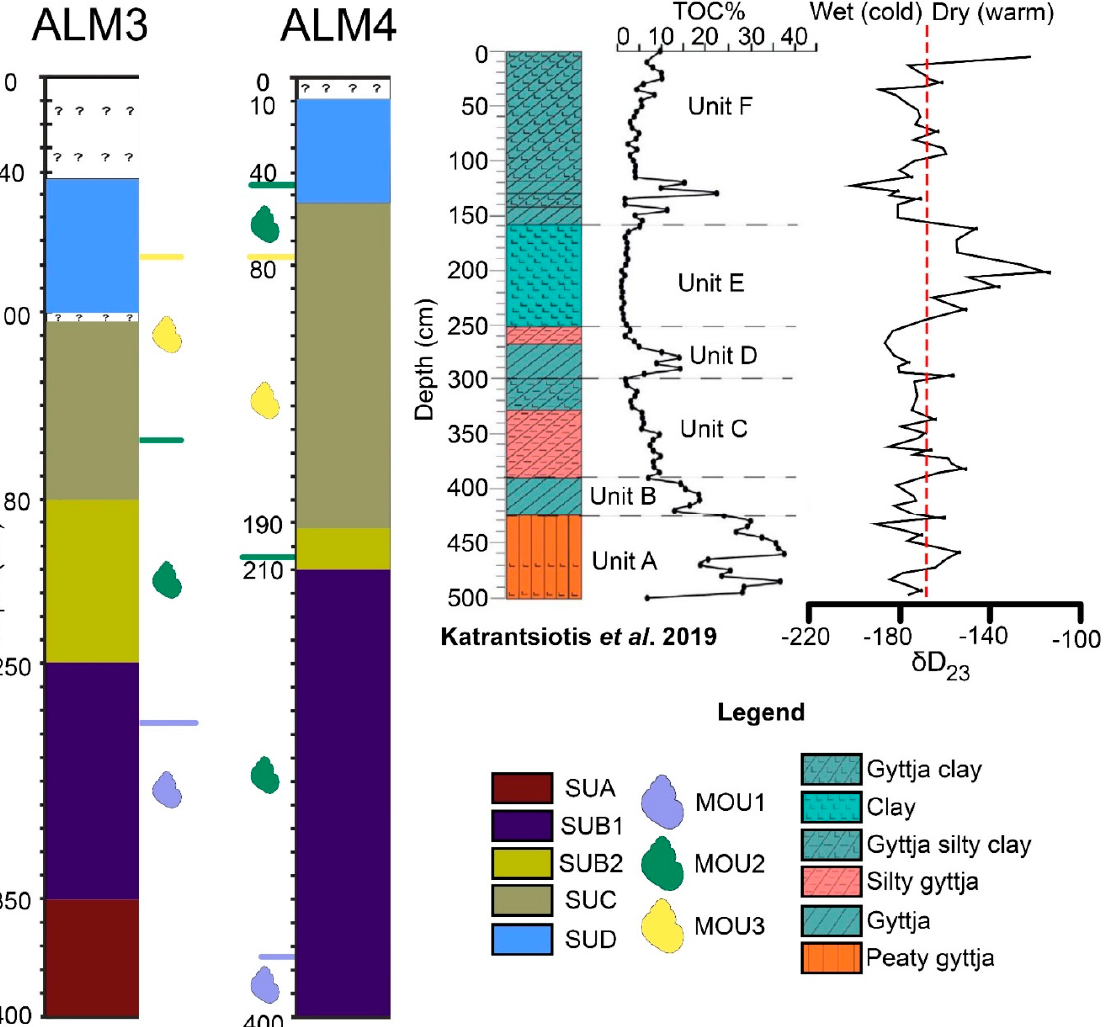
Figure 8. Combination of lithostratigraphic and palaeontological units for the cores ALM3 and ALM4. The question marks (?) are indicative of disturbed material during coring. Comparison with [12] (including TOC and δ D 23 data).